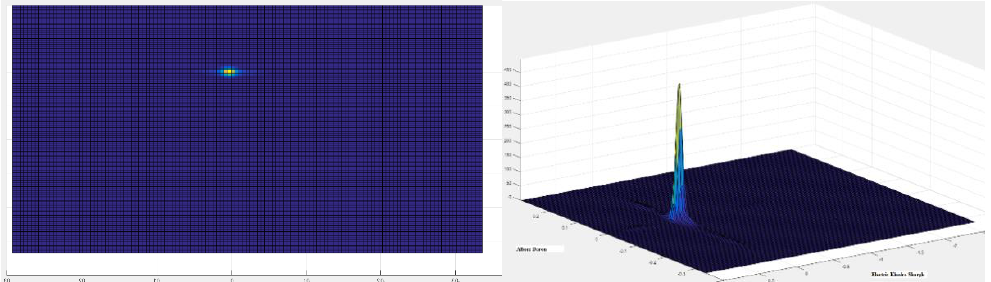
Figure 2.b. Horizontal Plot for Presentation the Joint PDF of “Electric Khodro Shargh” and “Alborz